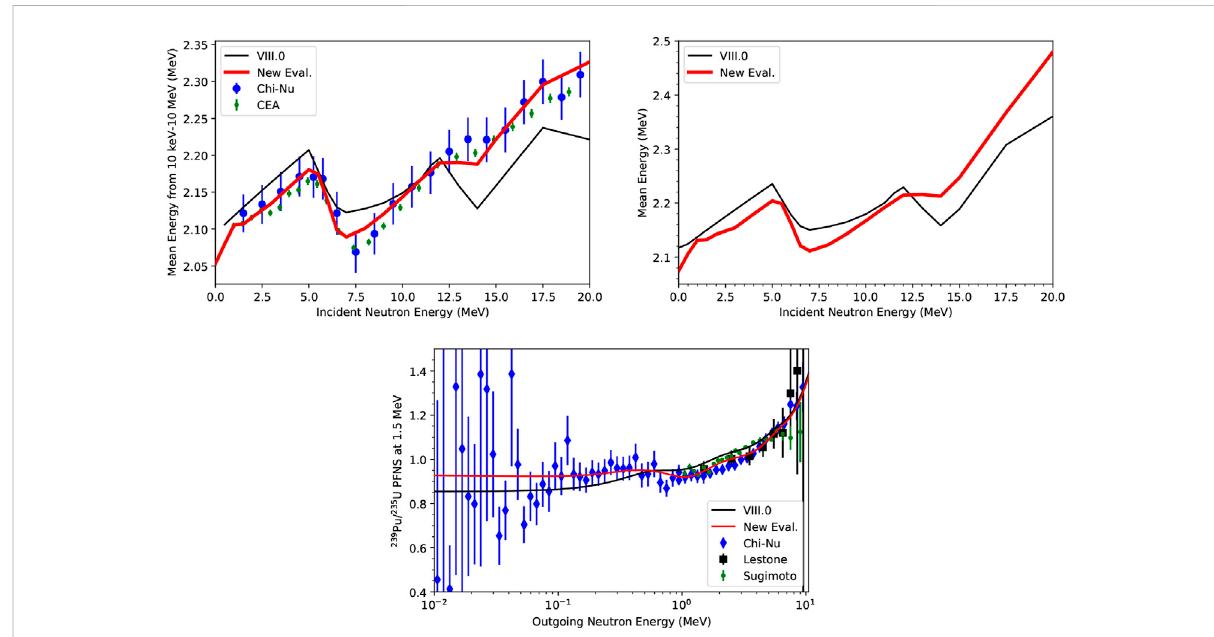
FIGURE 3 Further validation of evaluated PFNS is shown: (Top, right) Mean energies calculated from the PFNS from 100 keV to 10 MeV are compared for thisevaluation,ENDF/B-VIII.0andthosefromCEAandChi-Nuexperimentaldata.Atthermal,thePFNSfromINDENisadopted[13,73].(Top,left)The same as the fi rst plot but calculated mean energies are shown integrated over all E out . (Bottom) Ratio of 239 Pu/ 235 U PFNS at E inc = 1.5 are shown for ENDF/B-VIII.0, this evaluation and one for 235 U including Chi-Nu PFNS, Chi-Nu, Lestone and Sugimoto experimental